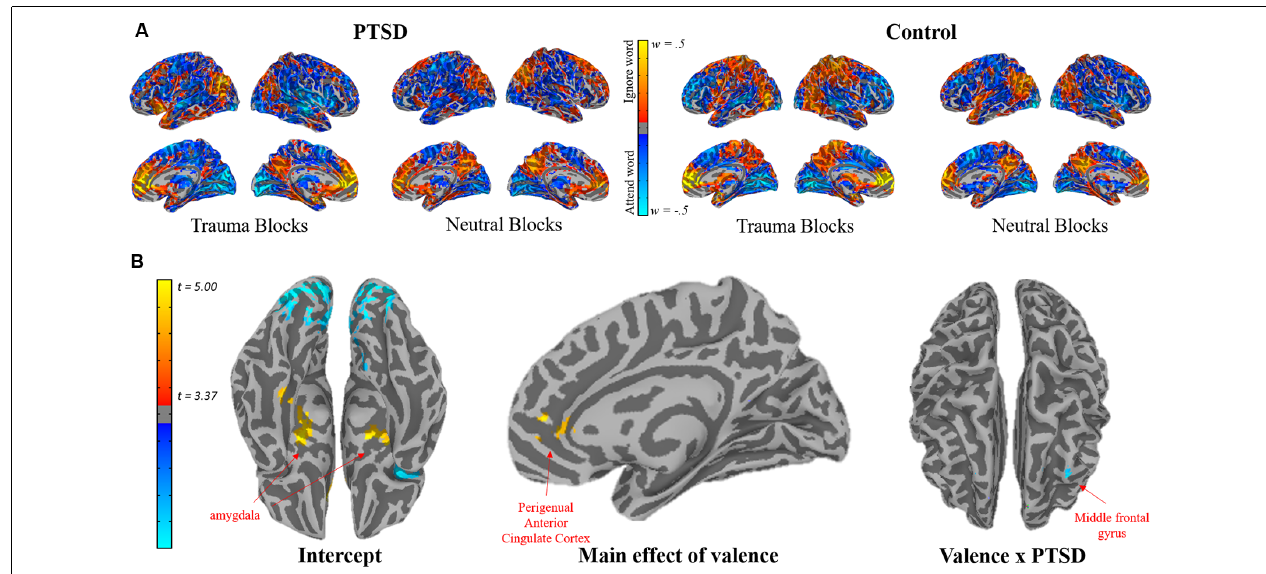
FIGURE 3 | (A) Surface renderings of the mean SVM feature weights for the PTSD (left) and control (right) groups, separated by blocks containing trauma words vs. neutral words. The SVM classifiers were trained to differentiate attention towards the word target vs. attention towards the face target (i.e., ignoring the word target). Each participant’s raw SVM feature map underwent a forward encoding transformation before calculating group means to allow the maps to be interpretable concerning the brain processes of interest (Haufe et al., 2014). (B) Significant clusters of activation from a group-level linear mixed-effects (LME) model, in which a given voxel’s feature weight is modeled as a function of valence (trauma vs. neutral word blocks) × group (PTSD vs. control), with additional covariates for age and education. The intercept (bottom left) represents the mean feature weight encoding of the voxel, independent of factors entered into the model. The main effect of valence (bottom middle) indicates a significant cluster of voxels in the medial prefrontal cortex that more strongly differentiated attention to words vs. faces when trauma words were present. The valence × PTSD interaction (bottom right) indicates a significant cluster where the impact of valence on the differentiation of attention to words vs. faces differed between PTSD and control participants.